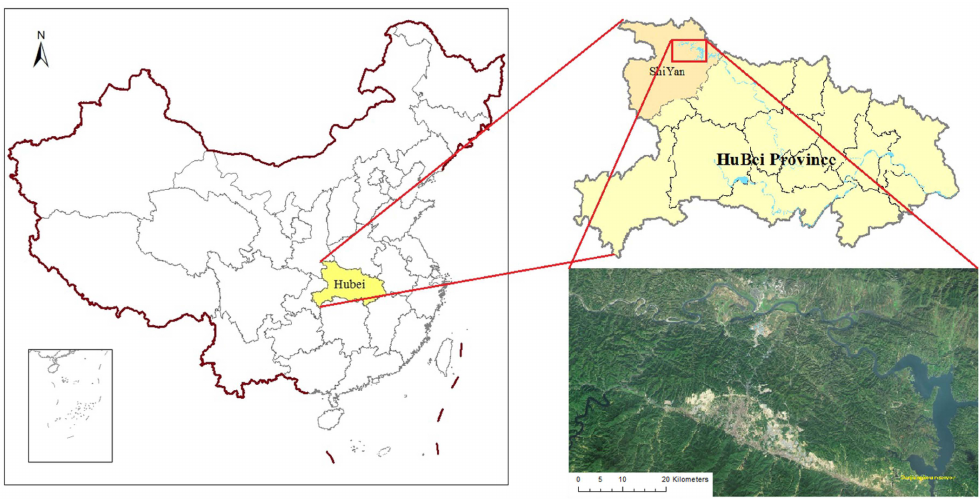
Figure 1. Location of the study area within the northwestern region of Hubei Province, China.